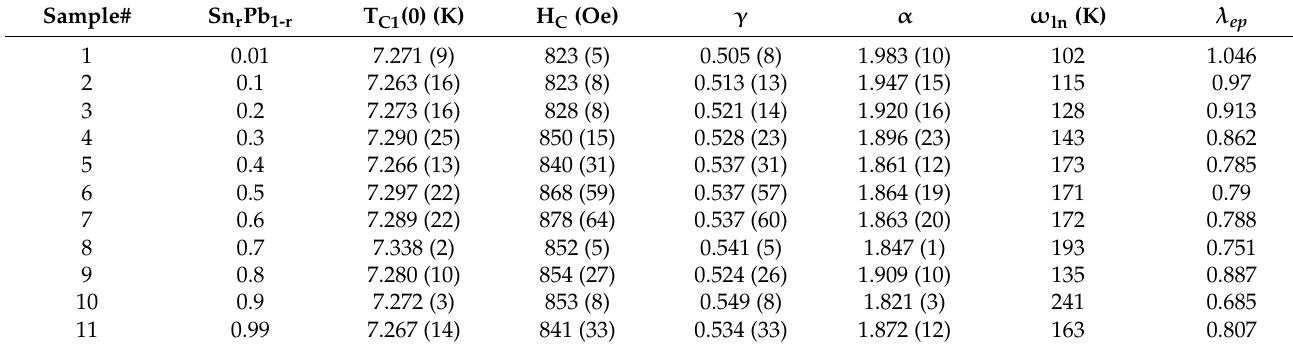
Table 3. Summary of obtained physical parameters, such as critical temperature T C1 (0), critical field H C (0), fitting parameters γ , coupling strength α , phonon energy ω ln , and electron–phonon